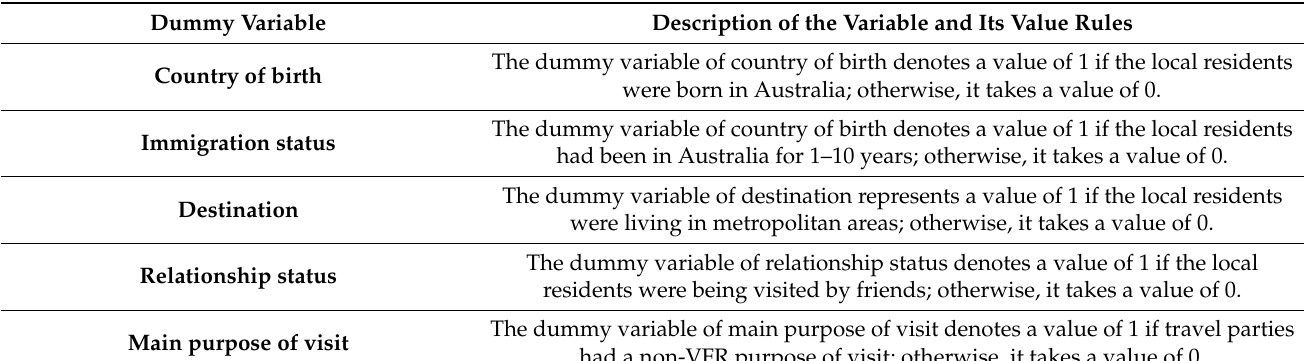
Table 3. Dummy variables used to examine the influence of VFR hosts.